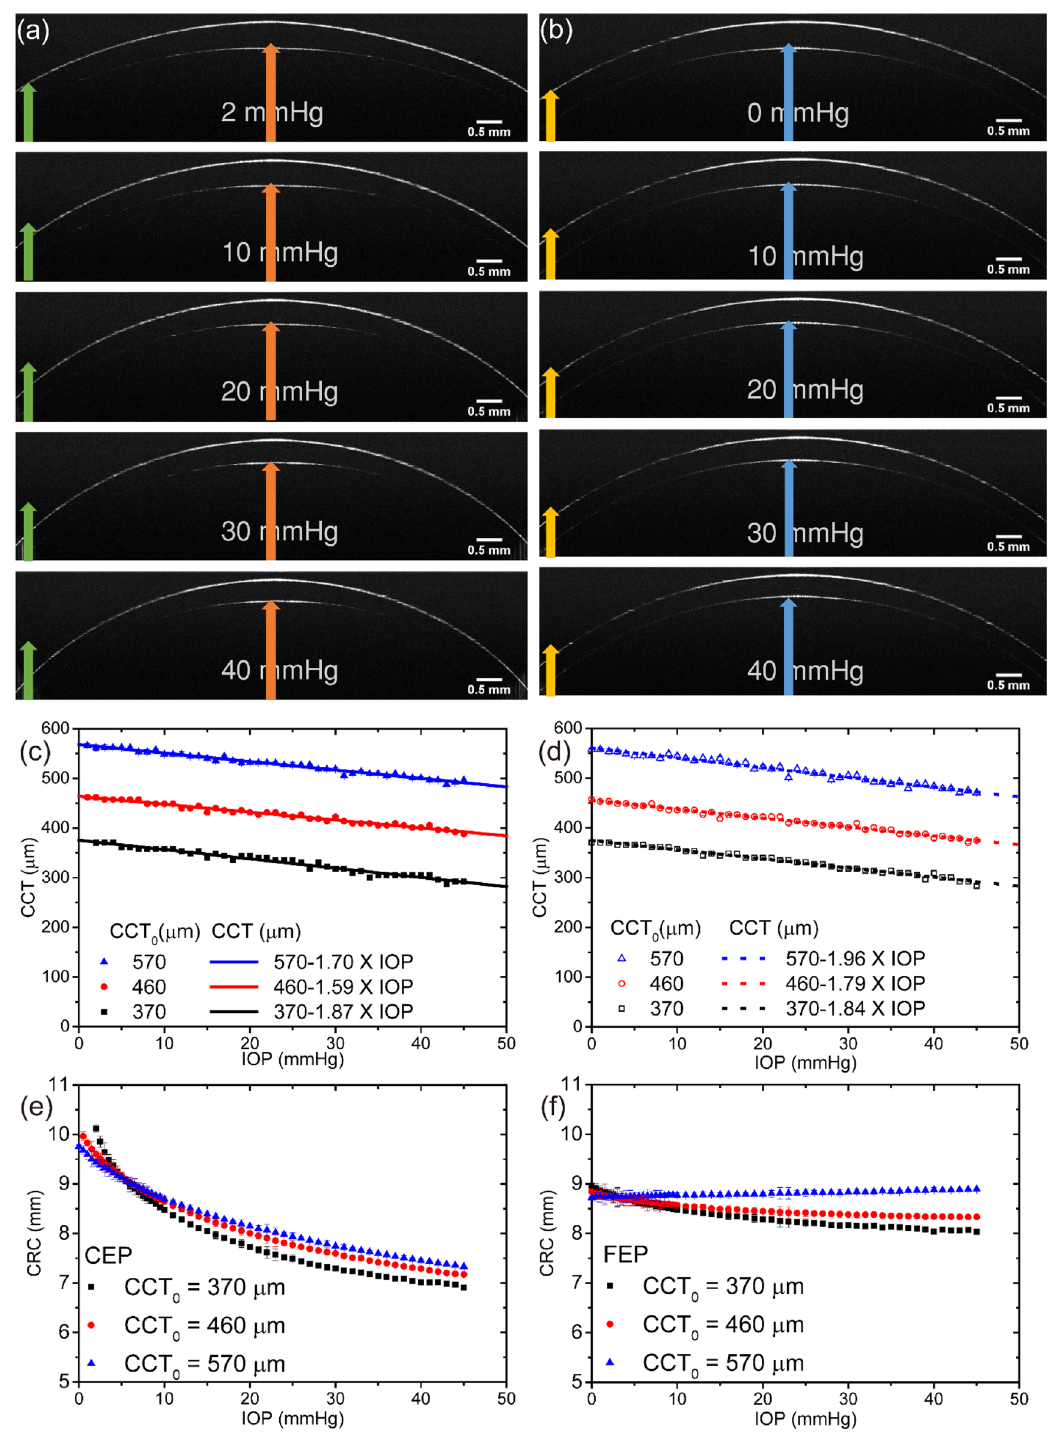
Figure 1. Optical coherence tomography images of cornea eyeball phantom ( a ) and full eyeball phantom ( b ) during changes in applied pressure. The CCT 0 of both phantoms is 370 μm. The scale bar is 0.5 mm. Arrows of the same color are the same size. ( c ) and ( d ) show the changes in the central corneal thickness of CEP and FEP, respectively. ( e ) and ( f ) show the corneal radius curvature for CEP and FEP, respectively, with changes in the applied